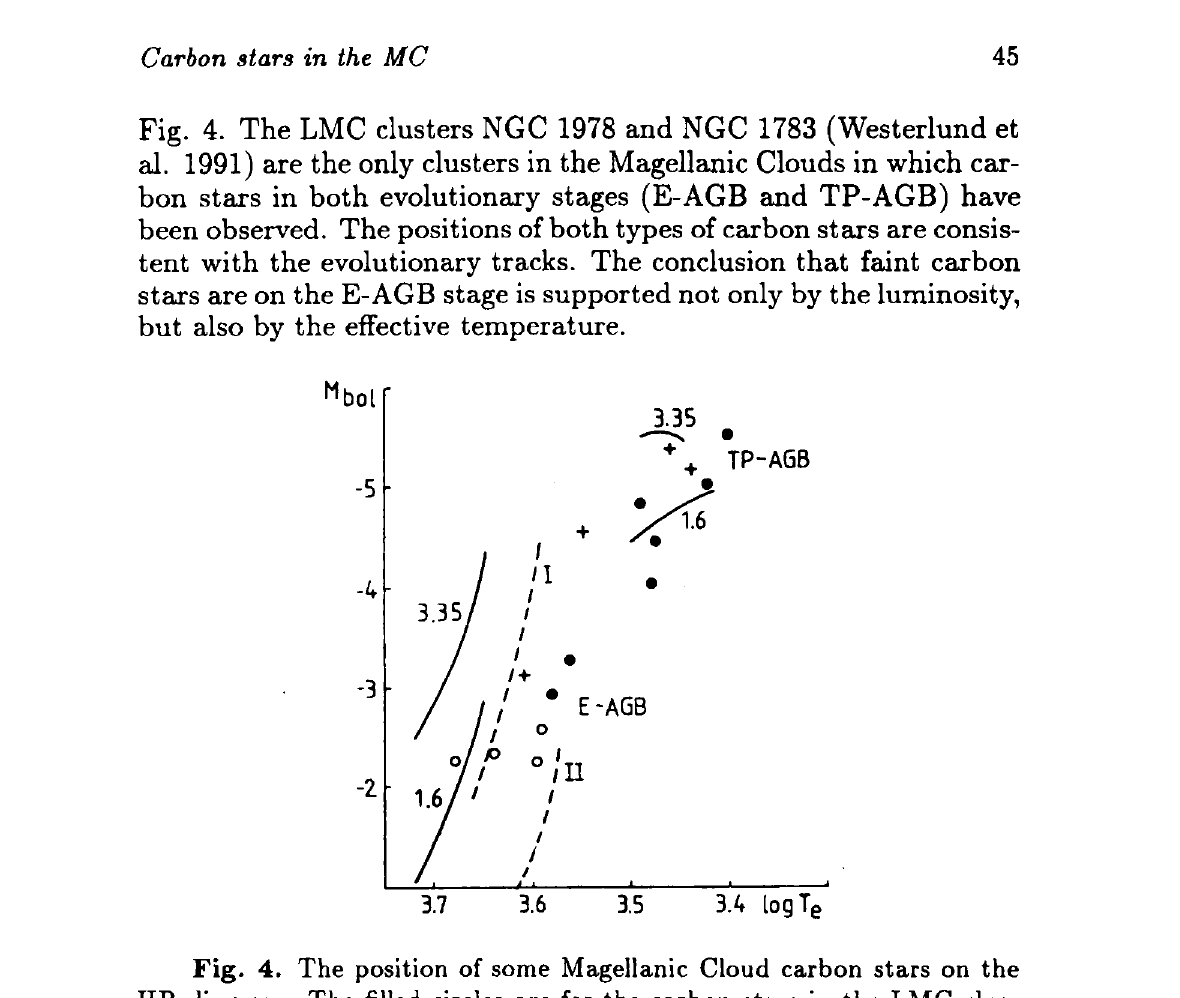
Fig. 4. The LMC clusters NGC 1978 and NGC 1783 (Westerlund et al. 1991) are the only clusters in the Magellanic Clouds in which car- bon stars in both evolutionary stages (E-AGB and TP-AGB) have been observed. The positions of both types of carbon stars are consis-